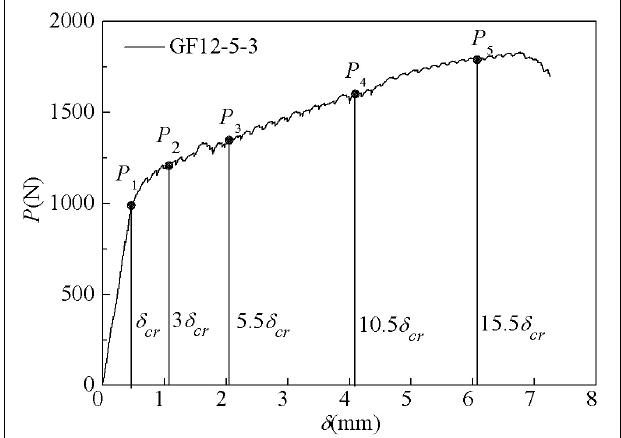
FIGURE 9 | Calculations of flexural toughness indexes of